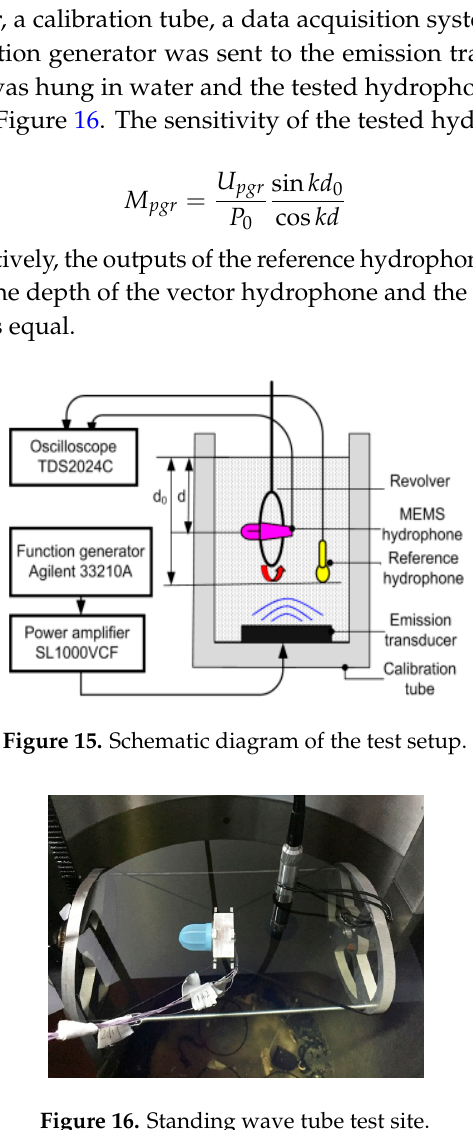
Figure 16. Standing wave tube test site.